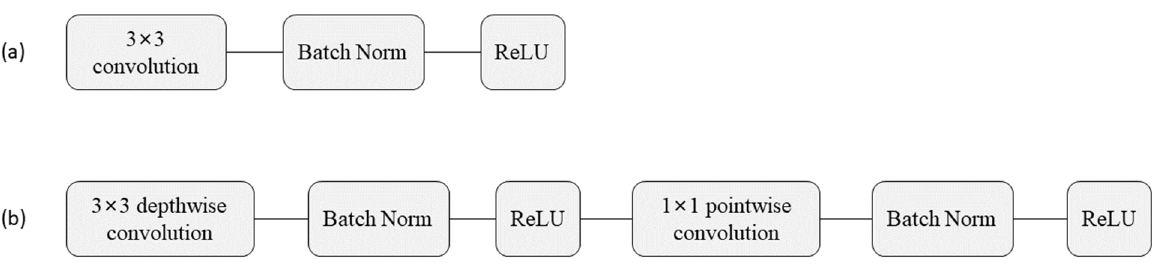
Figure 3. The specific process of convolution. ( a ): ordinary convolution, ( b ): depth-wise separable convolution.